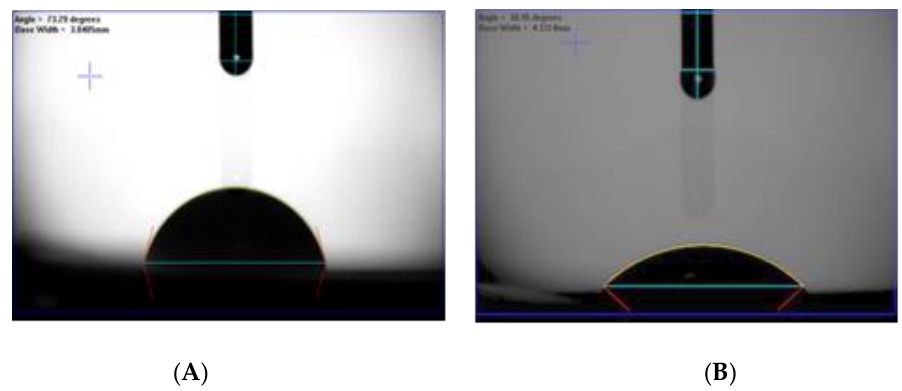
Figure 8. Images representing the contact angle of ( A ) the virgin PVDF and ( B ) the ZnO-MoS 2 photocatalytic membrane (PCM).